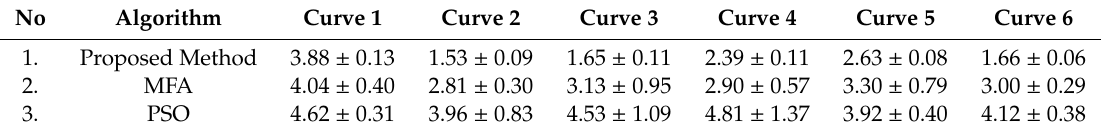
Table 5. Tracking times by